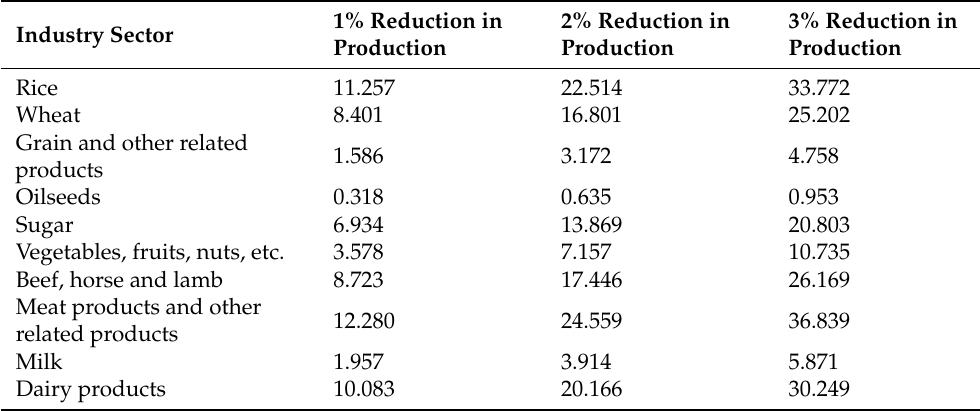
Table 4. Effect of yield changes on imports of different agricultural